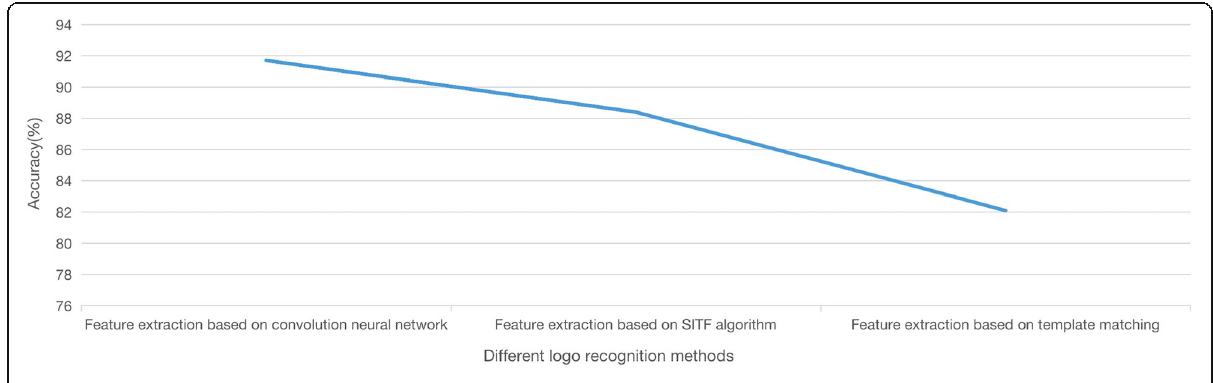
Fig. 6 Comparison of three kinds of feature extraction